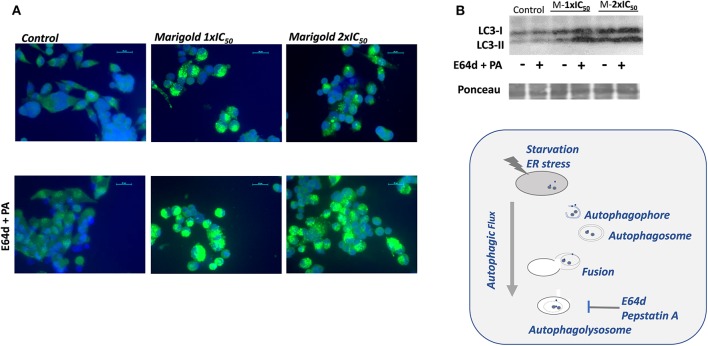
Effect of marigold SFE on induction of autophagy. (A) LC3 immunostaining. Representative images of control and marigold SFE-treated cells (48 h) at two different doses corresponding to 1 × IC50 and 2 × IC50, in the absence (left panel) or presence of E64d (10 μM) and pepstatin A (PA; 10 μg/ml) (right panel). Scale bar: 20 μm. (B) Effect of marigold SFE on LC3 lipidation in MiaPaca2 cells pretreated at two different doses corresponding to 1 × IC50 and 2 × IC50 for 48 h and control non-treated cells, in the presence/absence of E64d (10 μM) and PA (10 μg/ml).